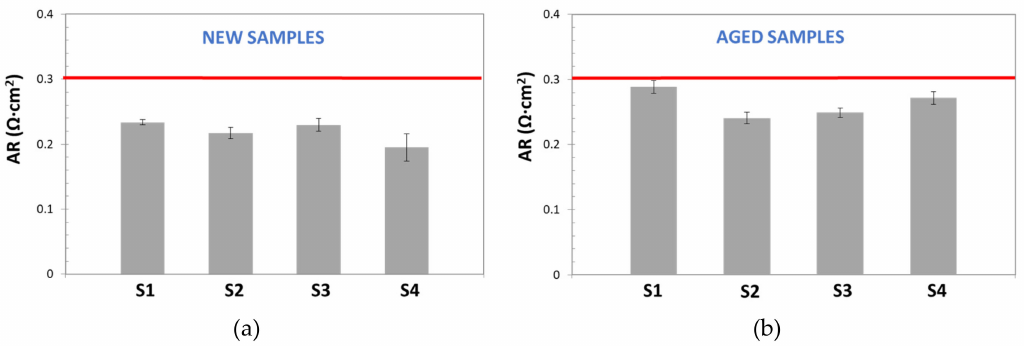
Figure 14. Area Resistance values calculated by EIS Method for: ( a ) new diaphragm samples ( b ) Used